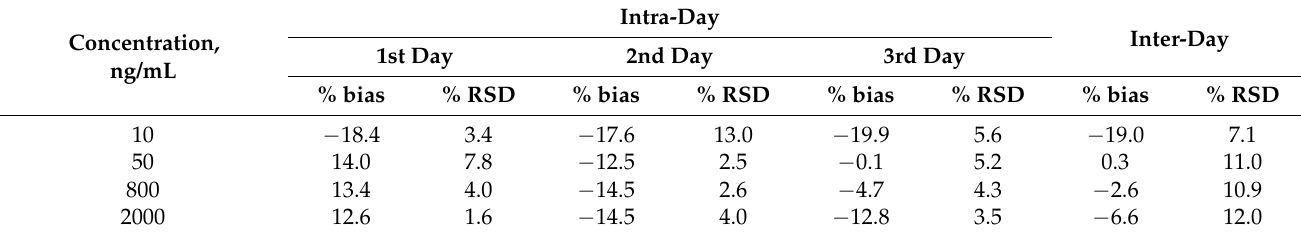
Table 1. Intra-day and inter-day accuracy and precision.